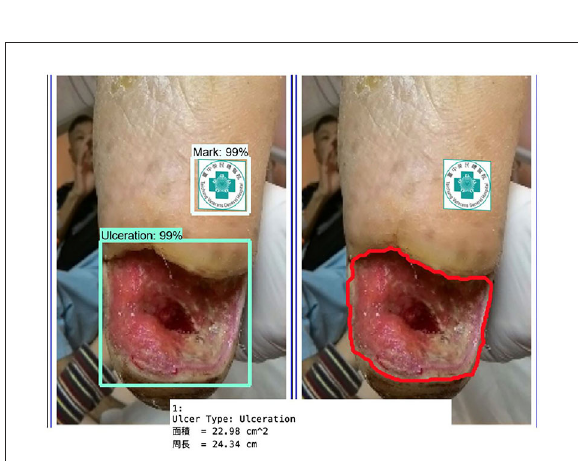
FIGURE14 Wound contour identification for the ulceration type of a DFU foot after medical